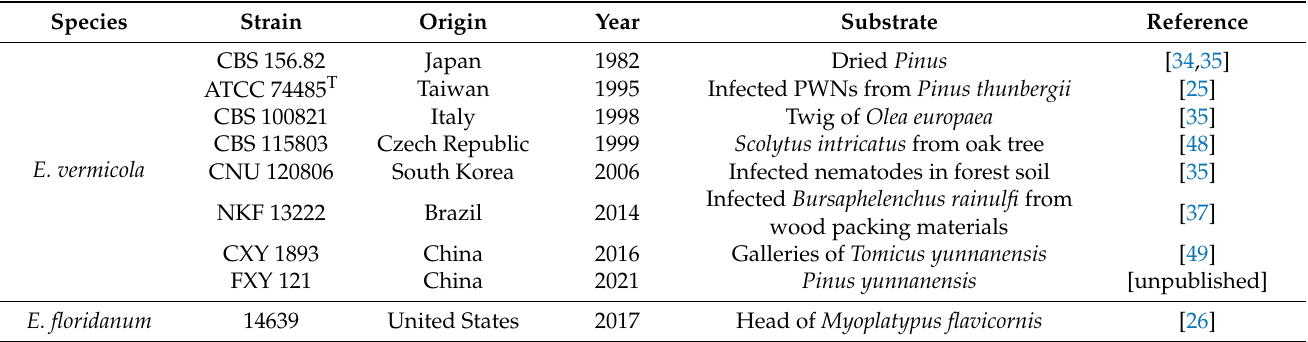
Table 1. Information on the species and isolates of Esteya currently described (T, type